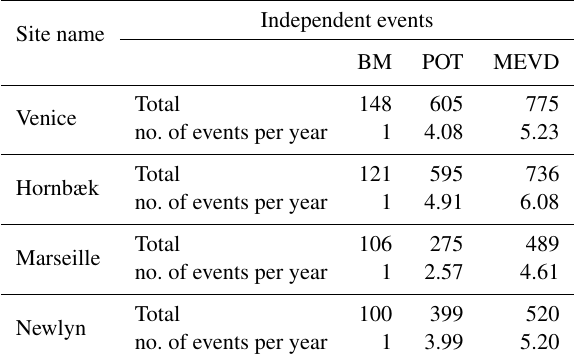
Table 2. Total number of independent events and average number of events per year for all the gauge stations